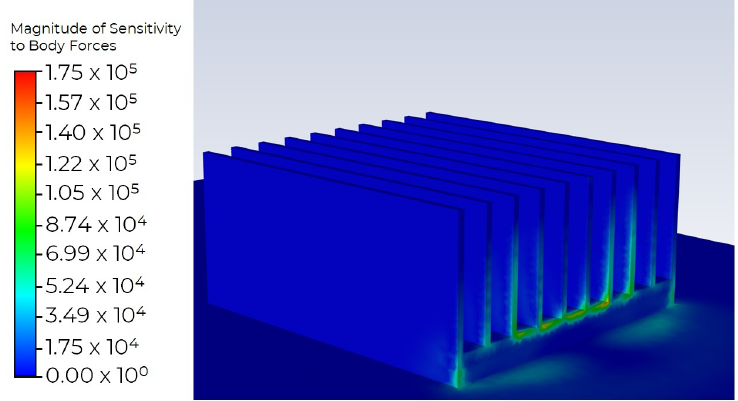
Figure 20. Sensitivity of the optimization criterion to mass forces.